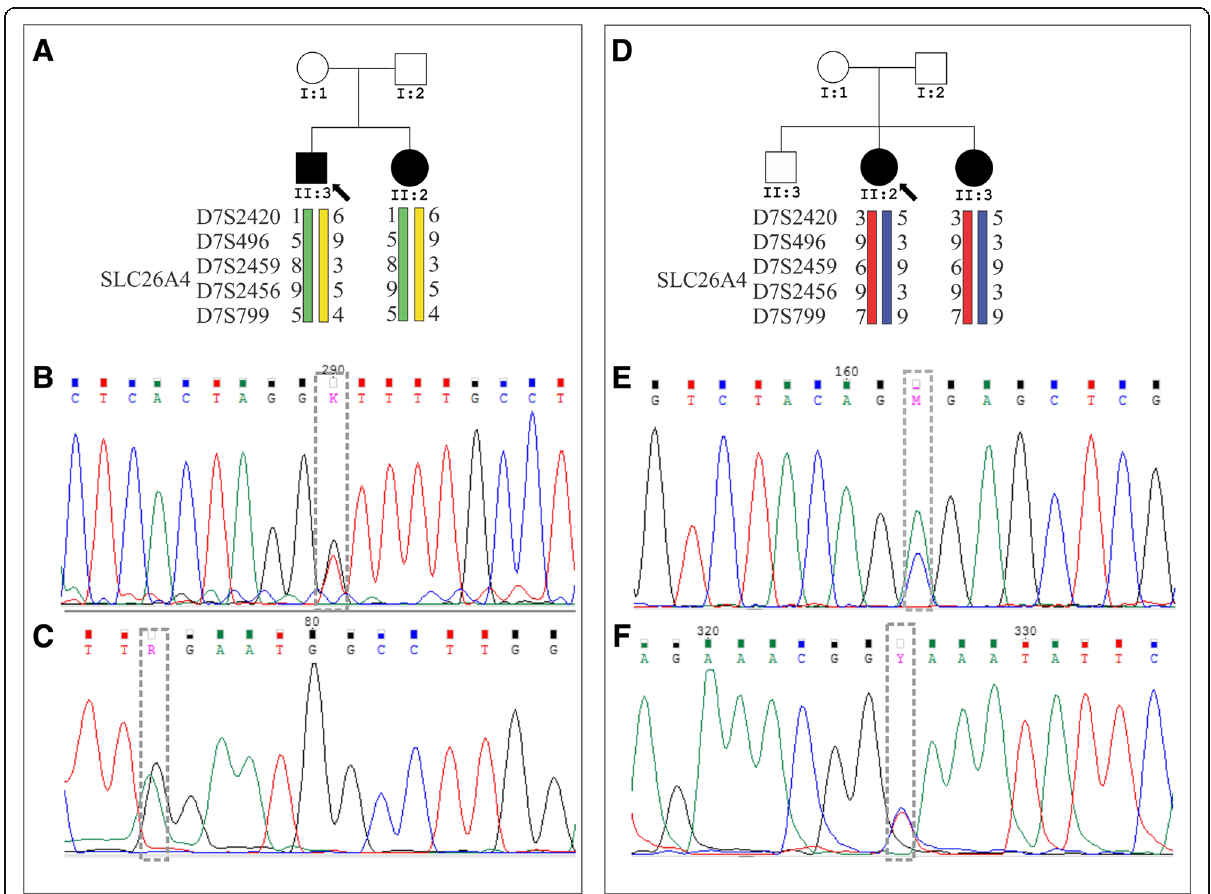
Fig. 1 Pedigrees of families 6 ( a ) and 24 ( d ) showing the segregation of the pathogenic mutations. Chromatograms showing the probably pathogenic mutations found to segregate with deafness in family 6 ( b and c ) and family 24 ( e and f